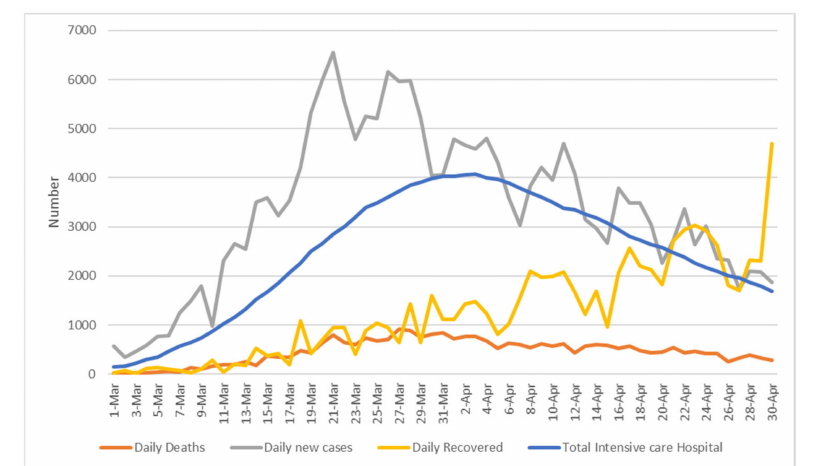
Figure 3. Daily variations of the parameters in the whole of Italy.